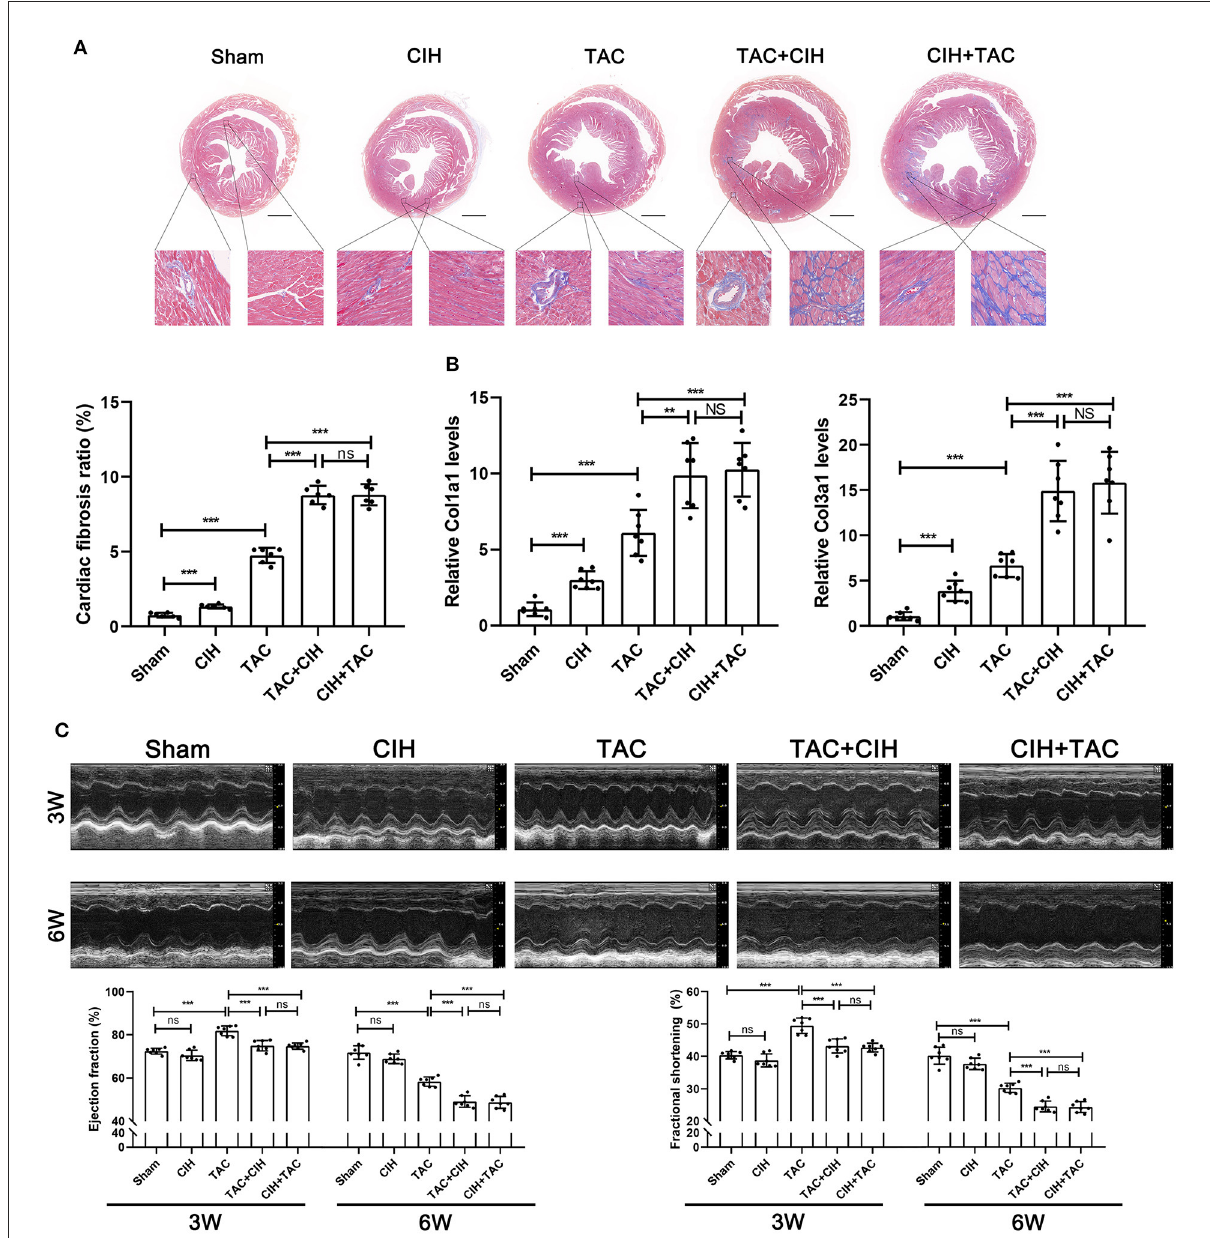
FIGURE2 CIH exposure accelerates cardiac fibrosis and cardiac dysfunction in mice subjected to TAC. (A) Masson staining of heart cross-section images and representative perivascular and interstitial fibrosis images magnified in boxes; the fibrosis area ratio was quantified. n = 7; ** p < 0.01, *** p < 0.001. (B) Real-time PCR analysis of relative Col1a1 and Col3a1 levels in heart tissue at week 6. n = 7; *** p < 0.001. (C) M-mode echocardiographic images of the left ventricle along the left parasternal long axis. Quantification of the LVEF and LVFS from the echocardiography data. n = 7; *** p <